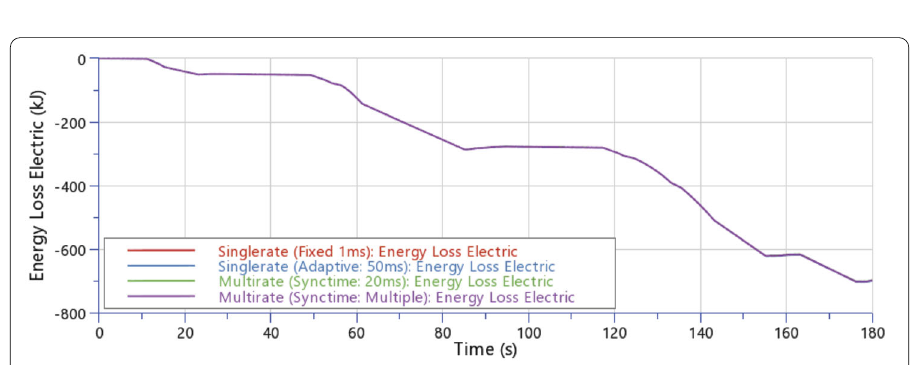
Figure 4 Comparison of the energy loss of the electric system of multirate cases against single solver cases for BEV with cooling system